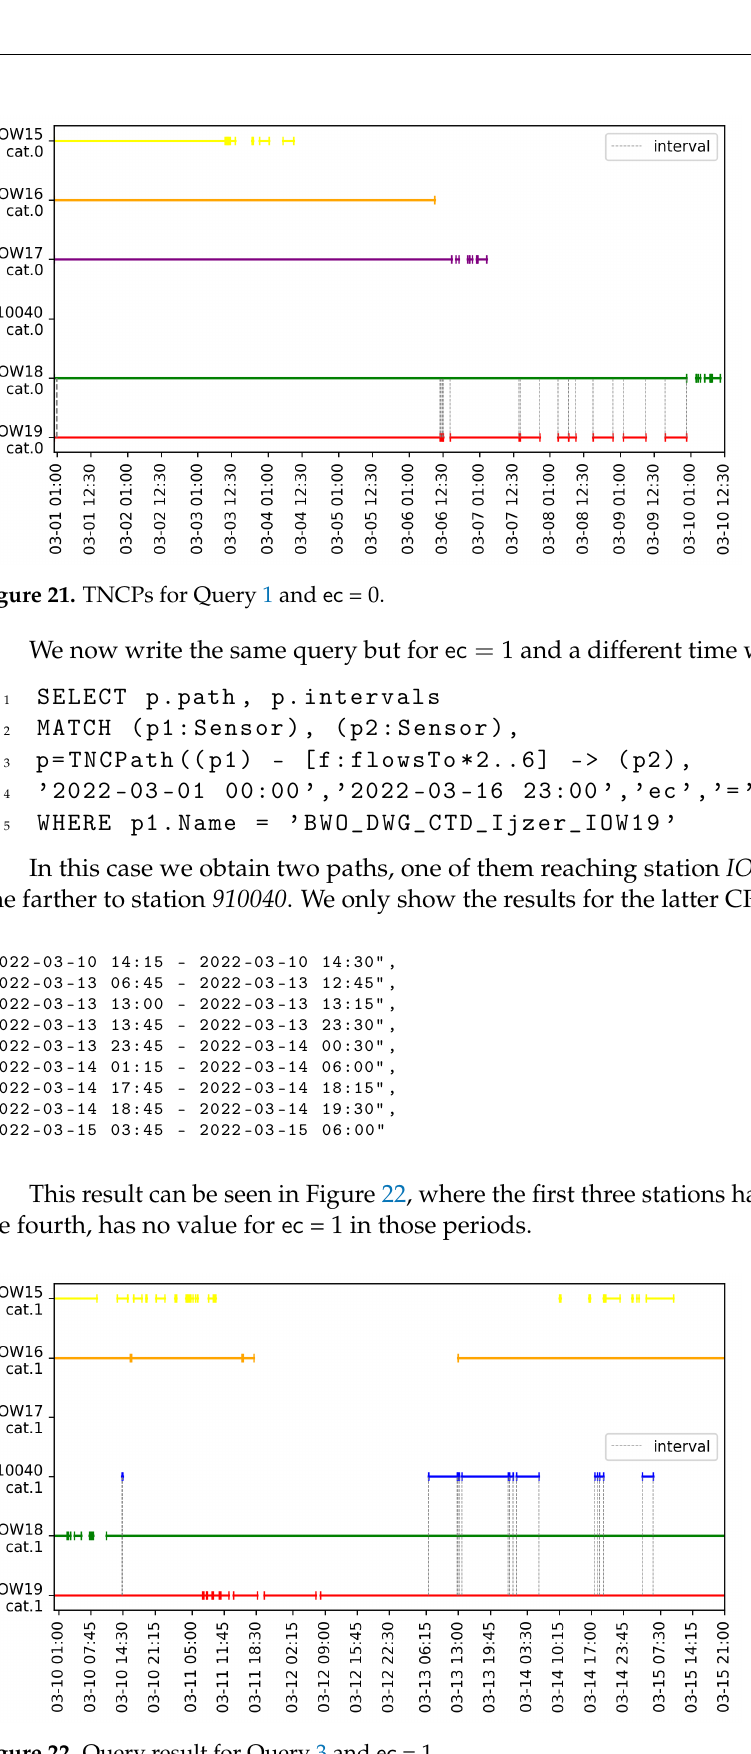
Figure 22. Query result for Query 3 and ec =